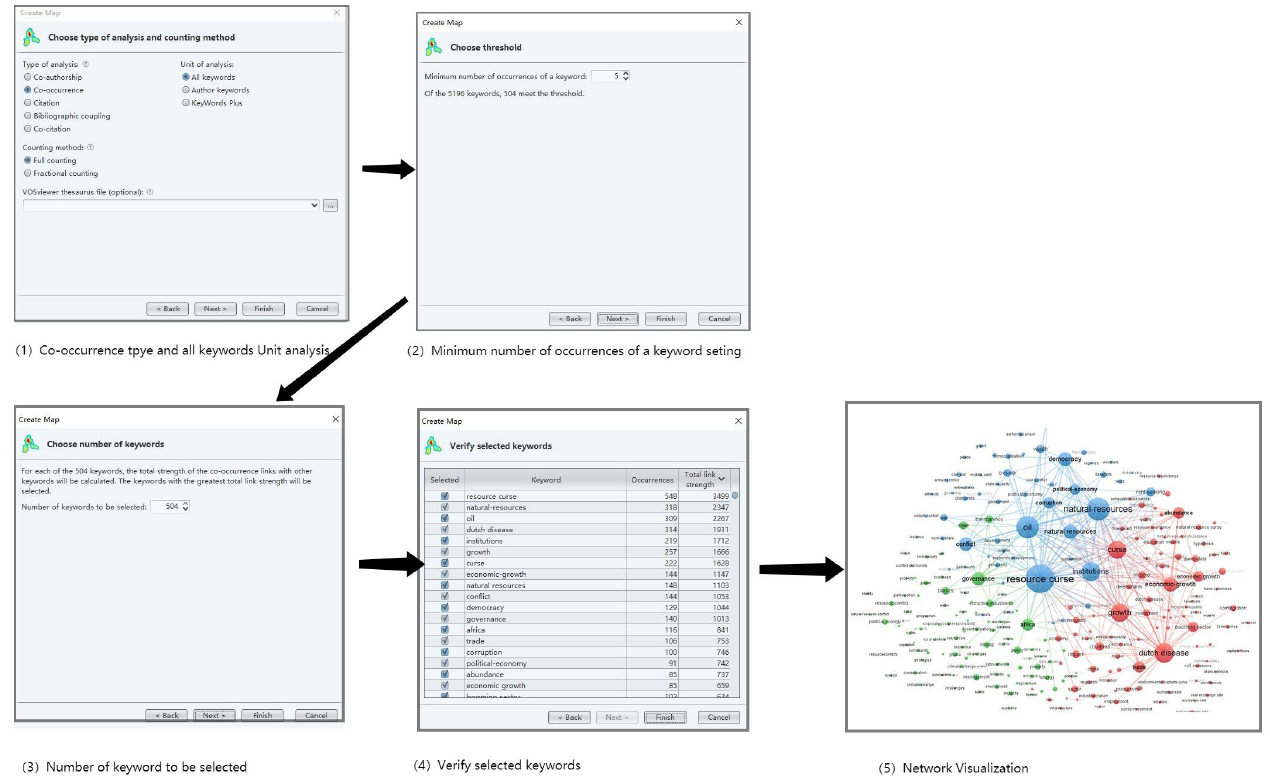
Figure 17. Integrated research mapping workflow of keyword network (using VOSviewer).